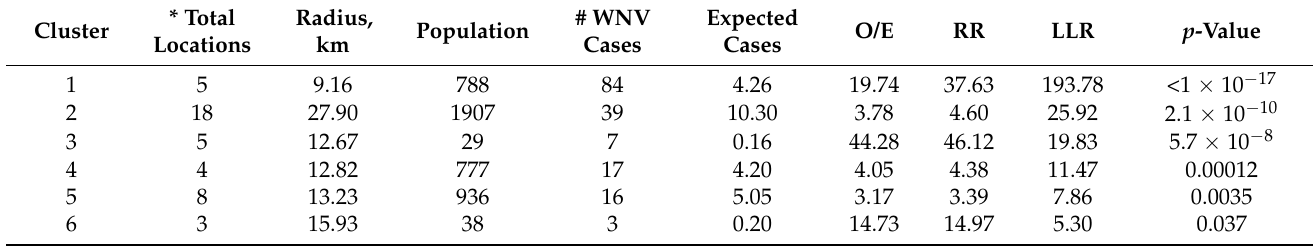
Table 1. SatScan TM purely spatial cluster analysis. The clusters of WNV cases detected by using purely spatial cluster statistics. Cluster